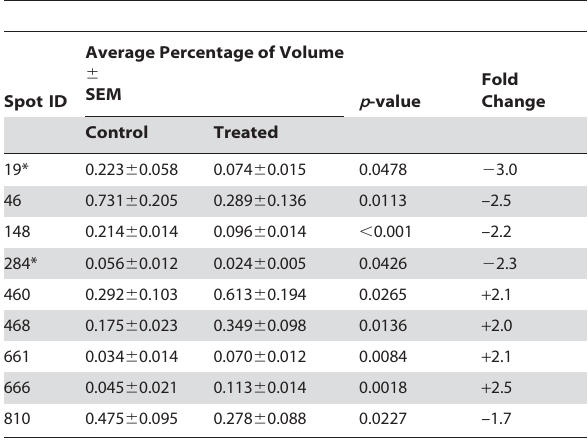
Table 1. Mean percentage of spot volume of proteins that were differentially